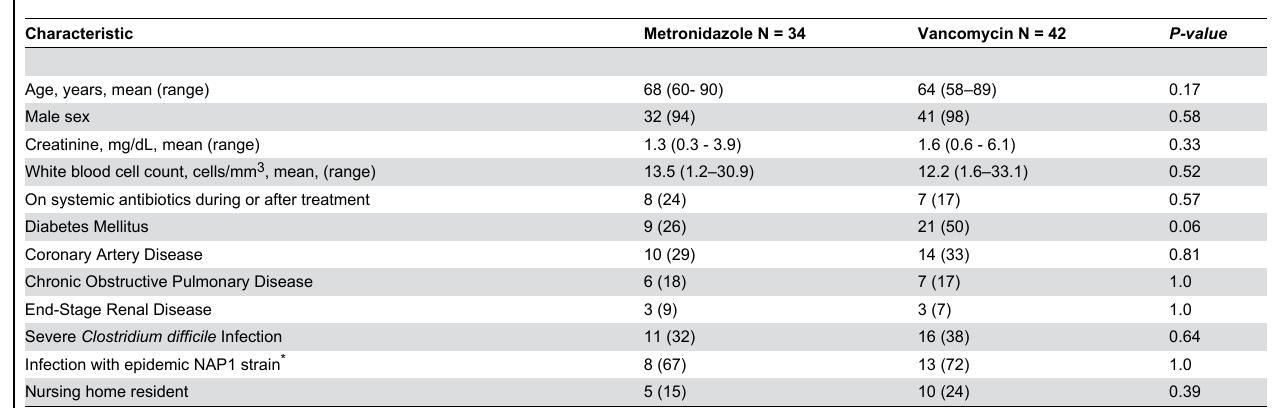
Table 2. Patient